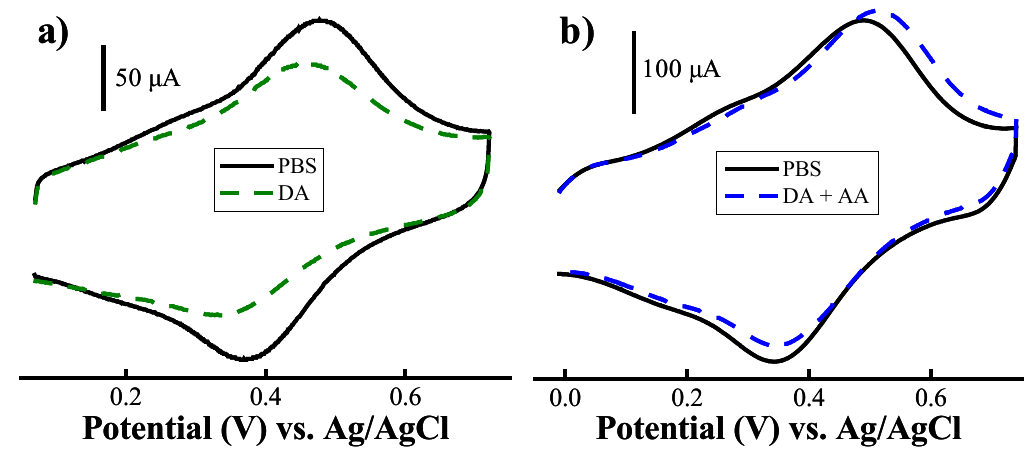
Figure 8. Cyclic voltammetric curves of the ss-DNA/SWNT/PABA modified Au electrodes in pH 7.4 PBS and upon addition of (a) 10 nM dopamine and (b) 10 nM dopamine and 0.15 mM ascorbic acid. Potential scan rate: 100 mV  s -1 . (Reproduced with permission from the American Chemical Society